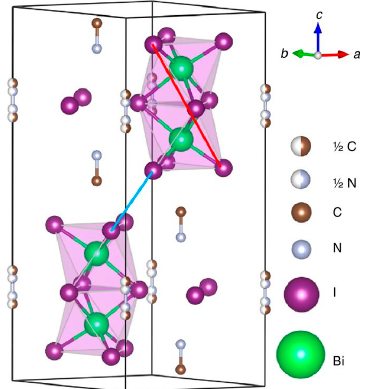
Figure 10. Schematic of the structure of (CH 3 NH 3 ) 3 Bi 2 I 9 which forms a zero-dimensional network. Bi 2 I 9 3- clusters are stabilized within a (CH 3 NH 3 ) + ionic lattice. Reproduced from ref. [82], with permission from Springer Nature, 2017 .